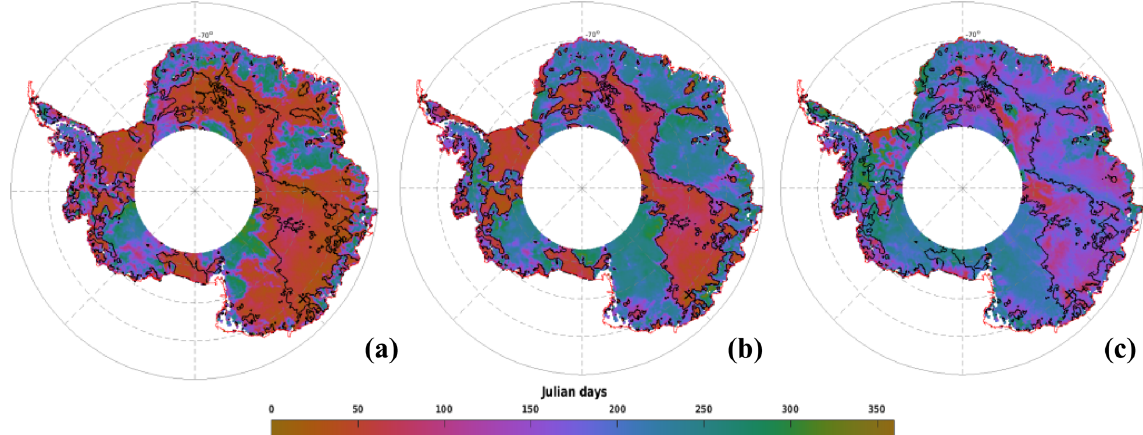
Figure 2. Spatial distribution of the seasonal date of maximum backscattering coefficient at the S (a) , Ku (b) and Ka (c) bands. Black contour lines delineate regions where the backscattering coefficient at the Ku band peaks before April. Blue defines a maximum in the winter while the magenta a maximum in the summer. The cross mark represents the location of the time series shown in Fig. 1. White areas indicate regions where no observations are available (latitudinal orbit limit of 81.5 ◦ S). Color bar is cyclic and defines Julian days.